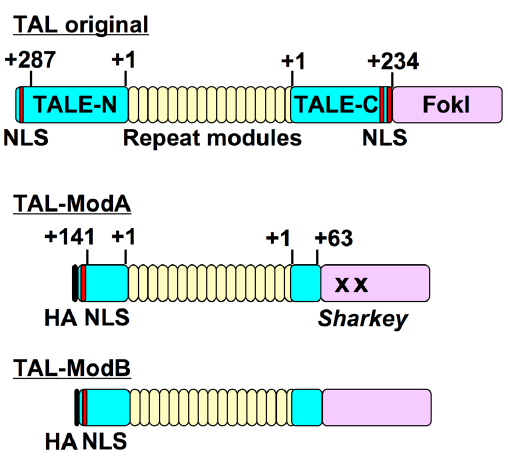
Figure 2. Modified TALEN structures. A, Original and modified TALEN structures. TAL-A and TAL-B contain truncated N-terminal ( + 141) and C-terminal ( + 63) TALE domains ( D N D C), and TAL-A also contains a mutated FokI, Sharkey , instead of the wild type. TALE-N, N-terminal TALE domain; TALE-C, C-terminal TALE domain; HA, hemagglutinin tag; NLS, nuclear localization signal. The amino acid sequences of these TALEN scaffolds and their numbering are shown in Figure S1.